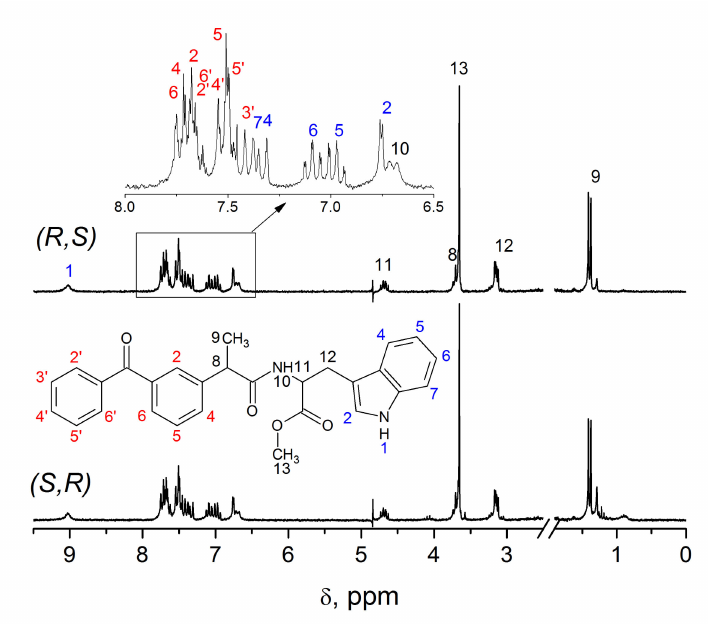
Figure 1. 1 H NMR spectra of 5 mM KP-Trp in acetonitrile-d 3 .